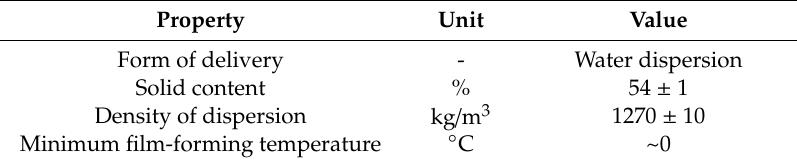
Table 2. Basic properties of polyacrylic ester